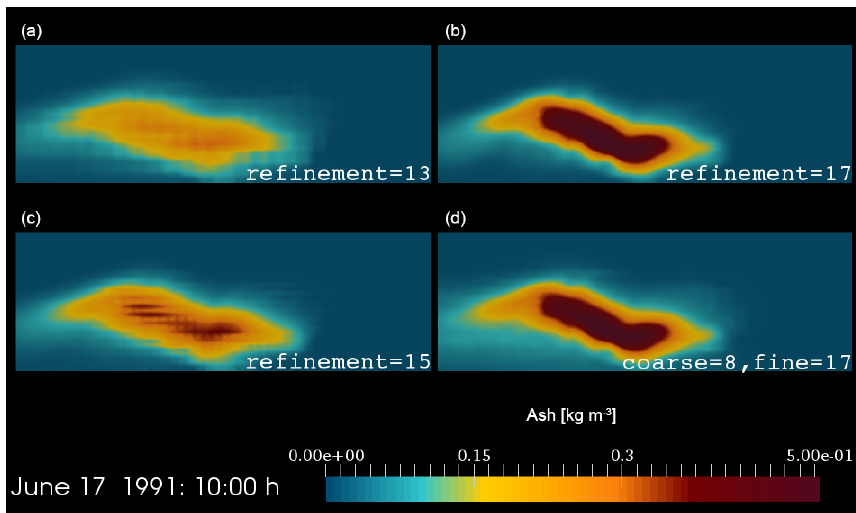
Figure 11. Cross sections at a height of 18km on 17 June at 13:20. Comparison between simulations on a uniform mesh with a refinement level of 13 (a) , 15 (c) and 17 (b) and a simulation on the adaptive mesh with a coarse-mesh level of 8 and a fine-mesh level of 17 (d) . The same figure including the mesh structure can be found in the online Supplement.